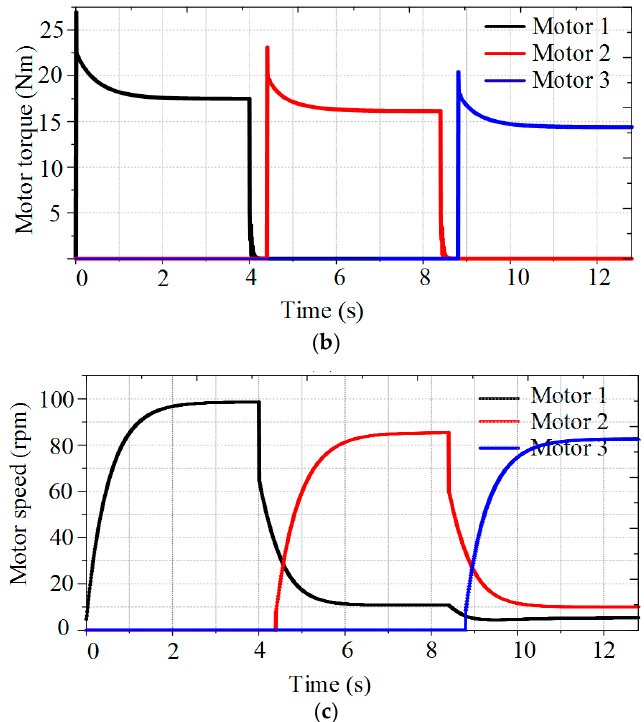
Figure 6. Dynamic selection of DC motors: ( a ) transmitter current; ( b ) motor torque; and ( c ) motor speed.